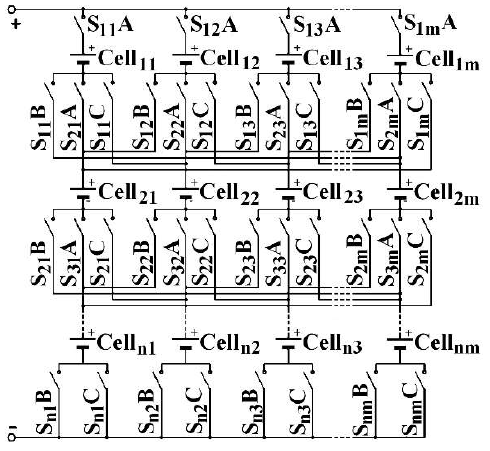
Figure 3. PS (parallel-series) architecture.